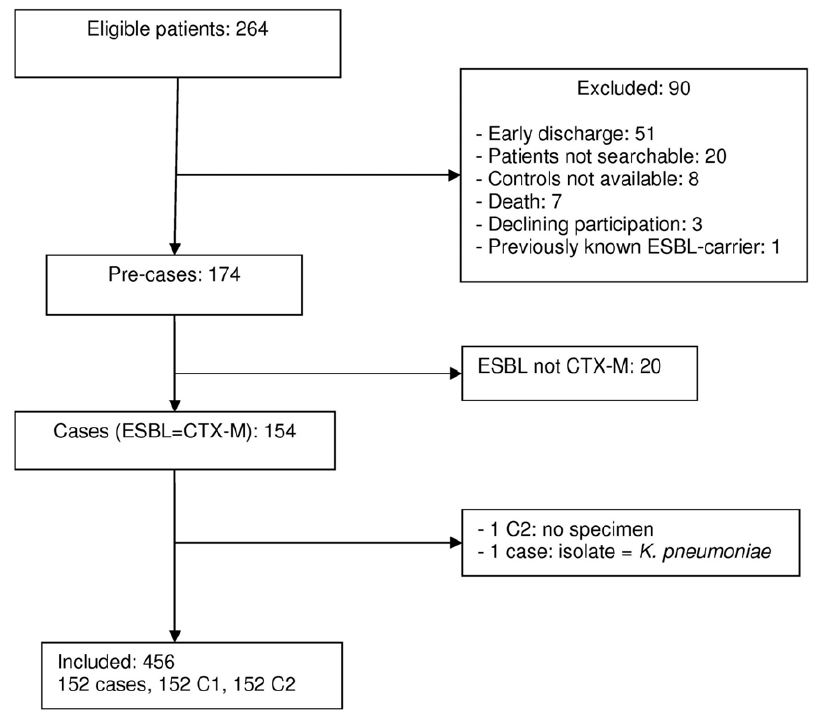
Figure 1. Flow chart for inclusion.